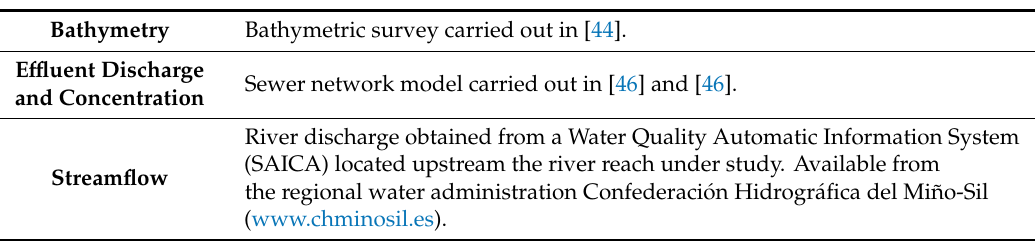
Table A3. Data sources for the Test Case 3.